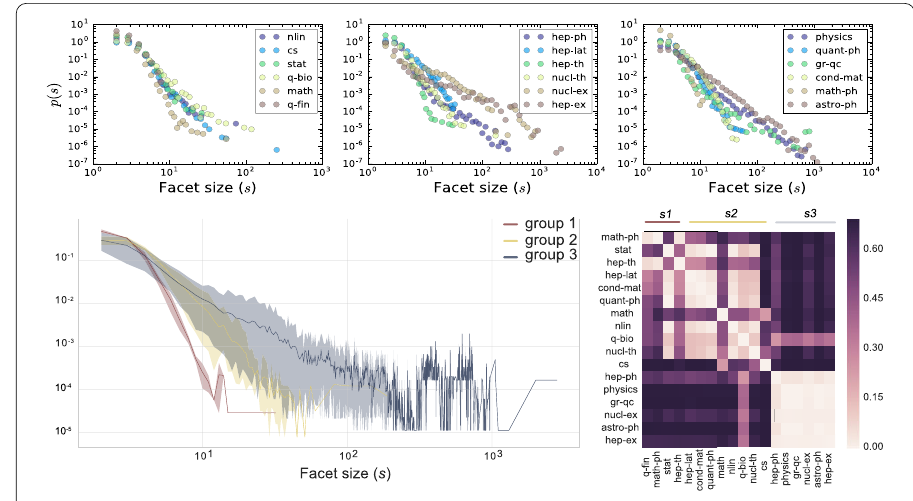
Figure 4 Comparison of facet size distributions. We show the facet size distributions (top) and their Jensen-Shannon divergence (bottom right) for all categories, ordered by max s value. We find three main blocks of categories, which we highlight with different colors (bottom left).